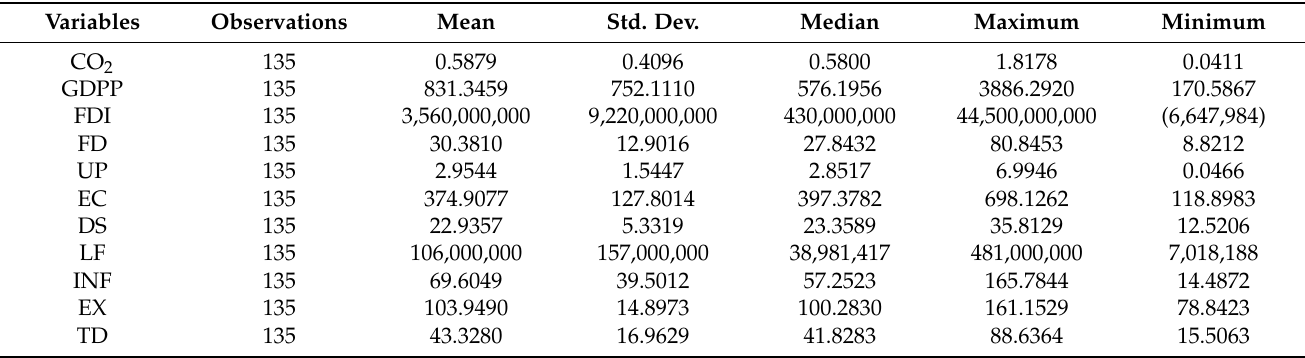
Table 2. Summary